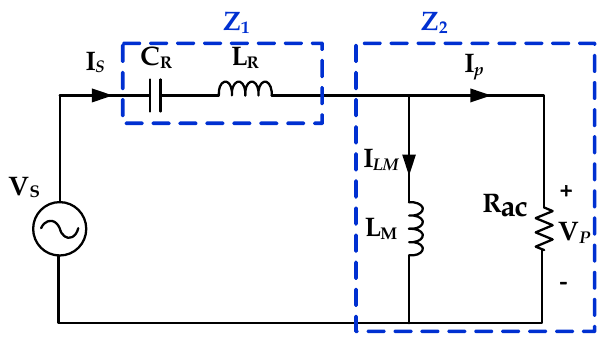
Figure 4. Equivalent circuit of AC resonant tank.